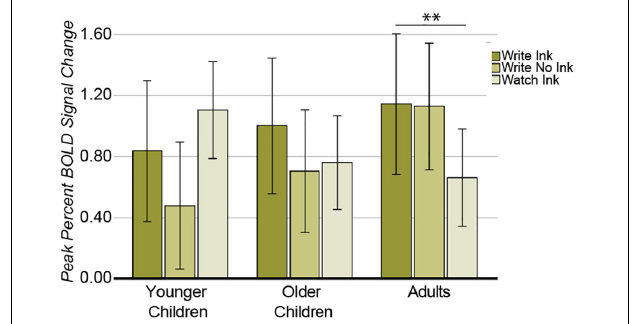
FIGURE 8 | Left ventral precentral gyrus. Interaction between AGE GROUP and CONDITION. Error bars represent 95% confidence intervals. ∗∗ p <